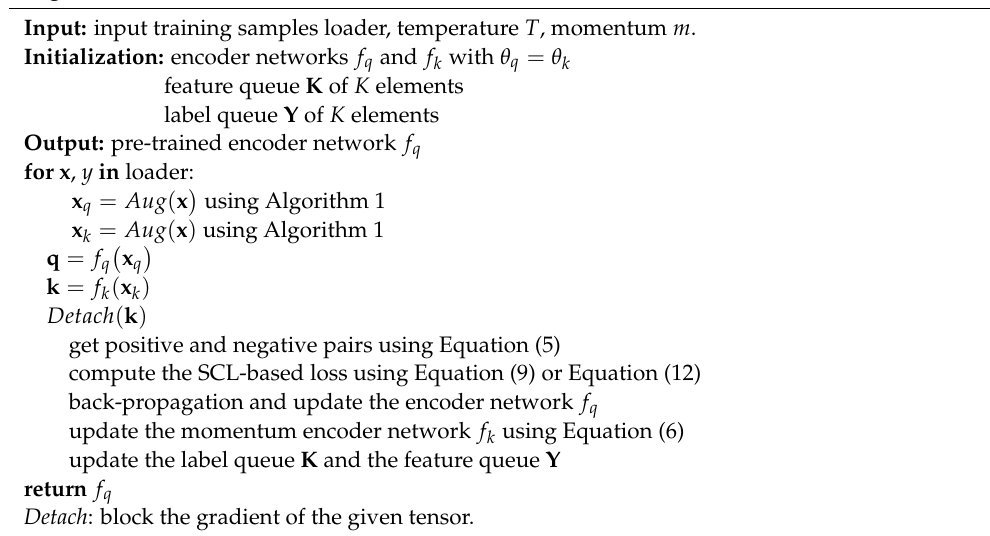
Algorithm 2 Pseudocode of SCL-based methods for HSI Algorithm 2. Pseudocode of SCL-based methods for